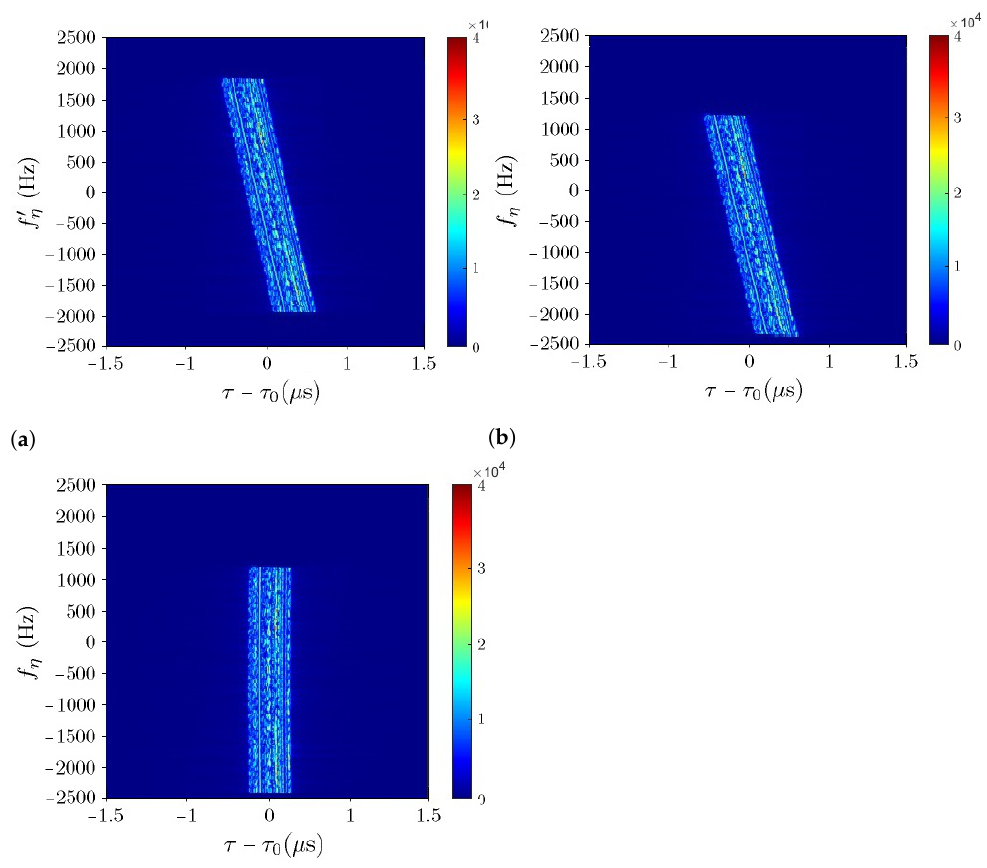
( τ , f (cid:48) ) , Doppler η 12